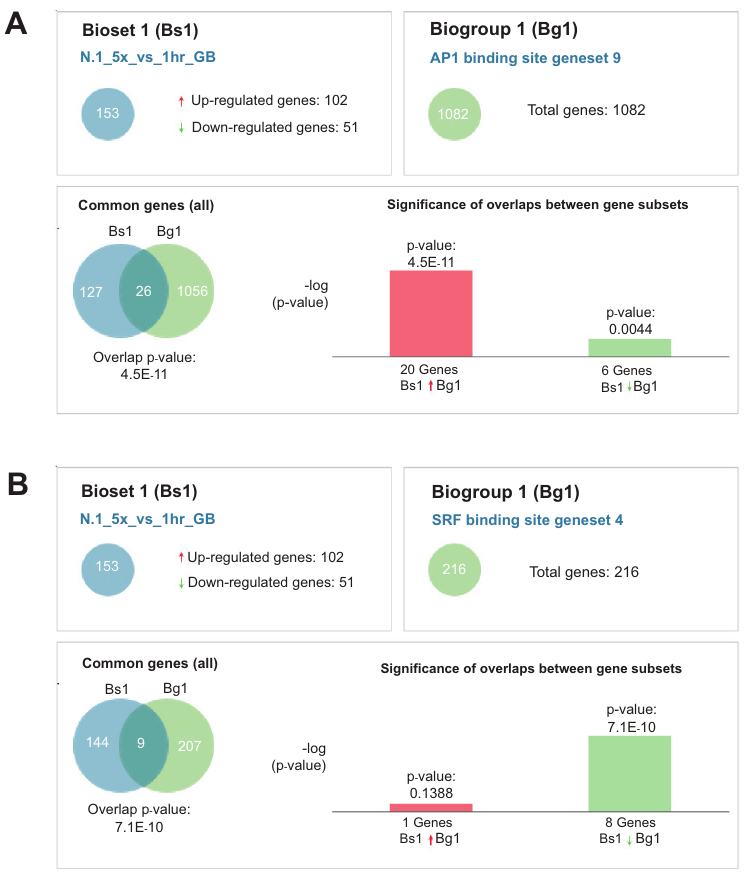
Figure S5. Enrichment of putative conserved AP1 and SRF binding sites in genes affected by NKX3.1 expression in LH cells as determined with NextBio. ( A ) The top panels summarize the datsets: Bioset 1 = 5× dataset of mRNAs affected by NKX3.1 expression; Biogroup 1 = AP1 binding site gene set according to 1 . The bottom panel illustrates the overlap between Bioset 1 and Biogroup 1 in a Venn diagram (left) and in bar graphs (right). The bar graph shows that most genes containing conserved AP1 binding sites are activated by NKX3.1 expression. The individual genes are indicated in Supplementary Table 1 and Supplementary Table 2. ( B ) Same as above for serum response factor